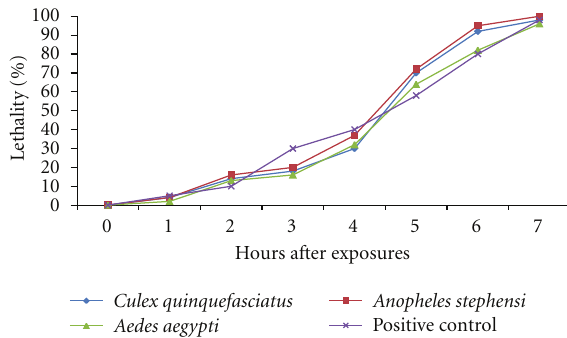
Figure 2: E ff ect of culture filtrates of Aspergillus niger against Culex quinquefasciatus , Anopheles stephensi , and Aedes aegypti after exposure of 7 hours.